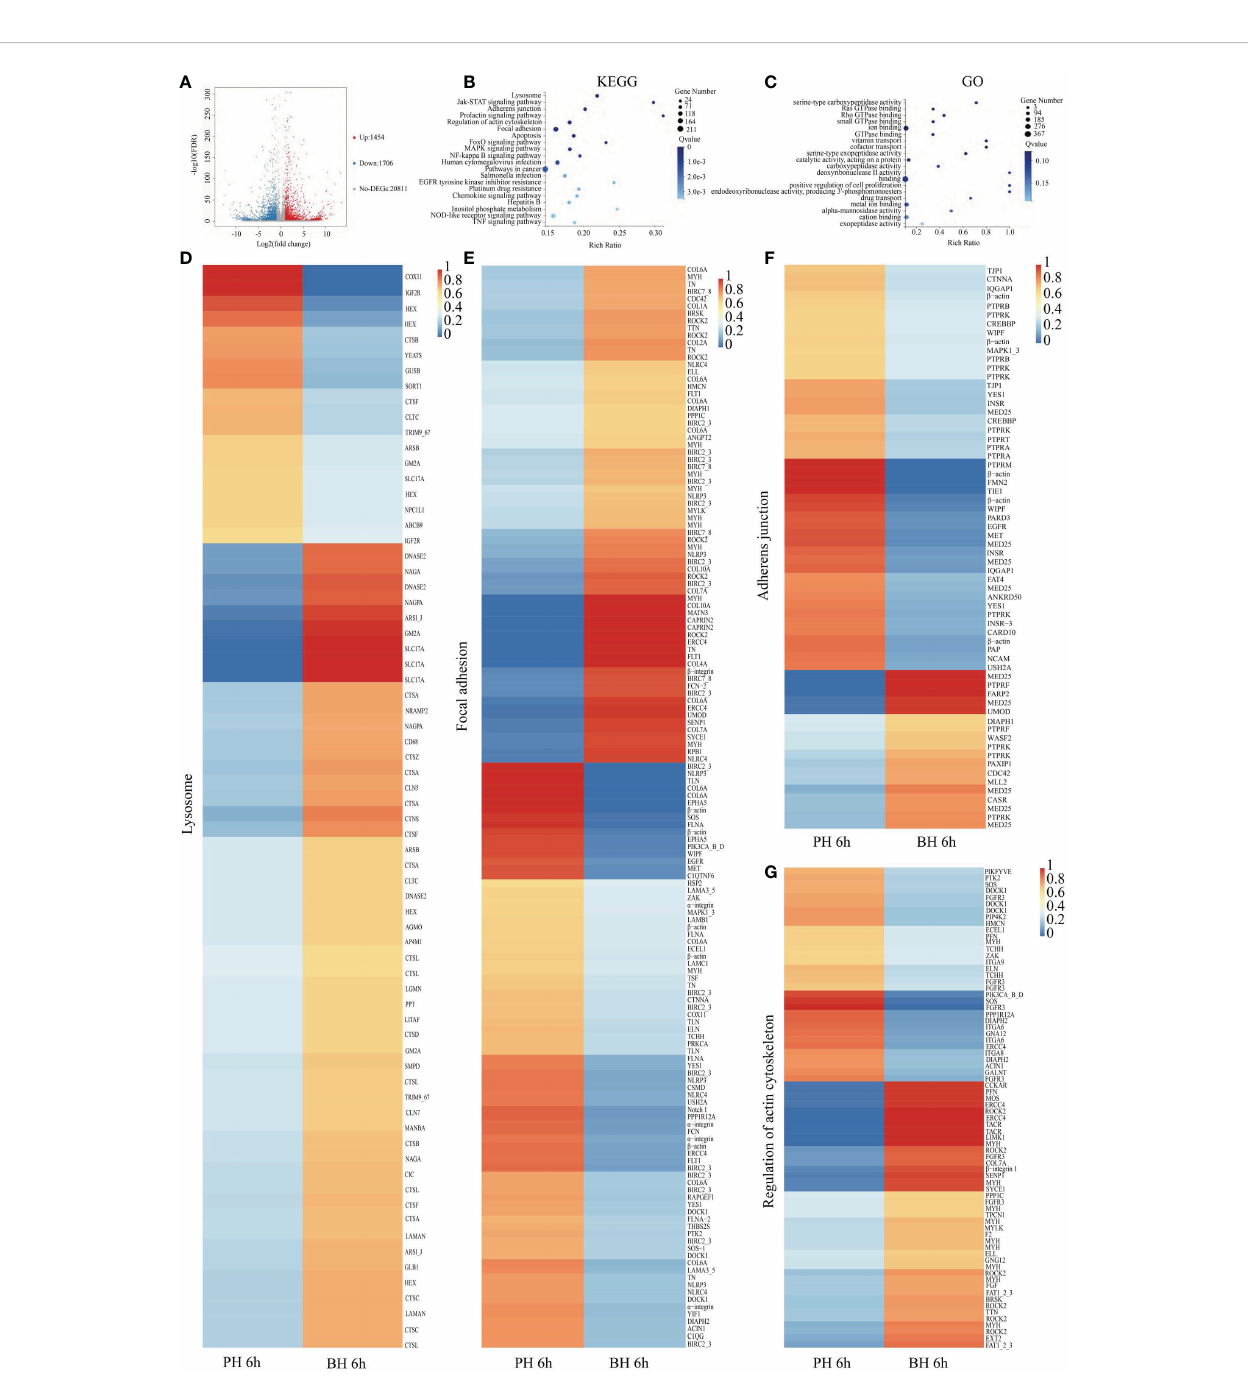
FIGURE 2 Analysis of DEGs between BH and PH group after transplantation 6 (h) (A) . Volcano map of DEGs between BH and PH groups after transplantation 6 (h) Impacted pathway (B) and GO (C) of butyrate on the genes regulated by transplantation. Expression of the related genes in the Lysosome (D) , Focal adhesion (E) , Adherens junction (F) , Regulation of actin cytoskeleton (G) in PH and BH groups after transplantation 6